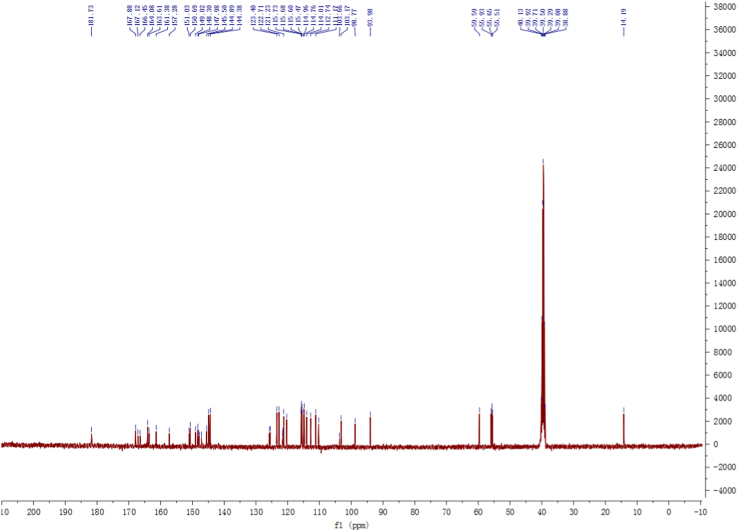
13C-NMR and DEPT spectrum of compound 2.